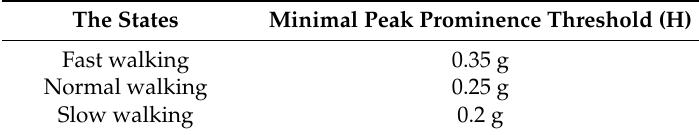
Table 2. The minimal peak prominence threshold for fast walking, normal walking, and slow walking states. The States Minimal Peak Prominence Threshold (H) Fast walking 0.35 g Normal walking 0.25 g Slow walking 0.2 g